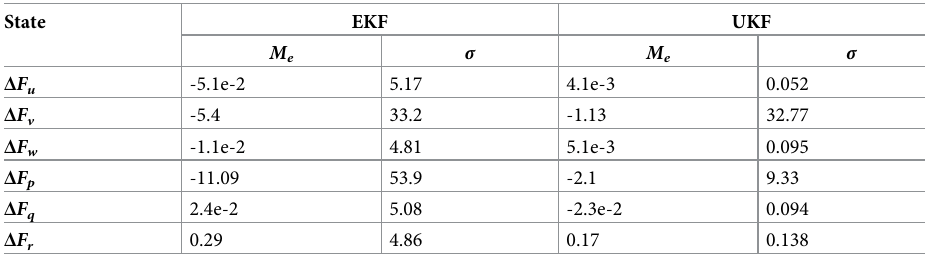
Table 5. Case 3: Mean estimation error for all states.